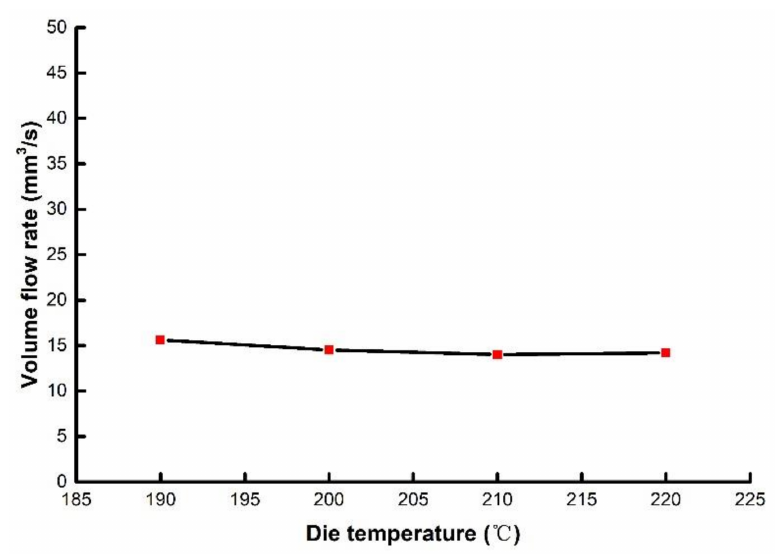
Figure 13. The relationship between die temperature and volume flow